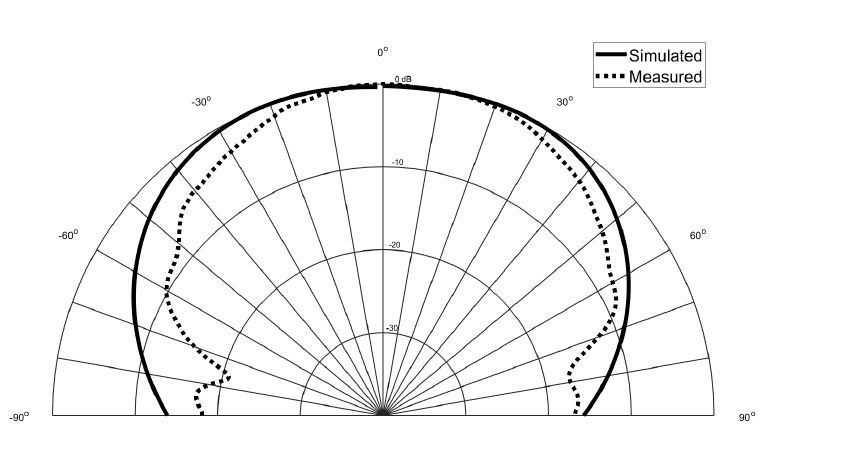
Figure 16. Simulated and measured radiation pattern of the squared patch